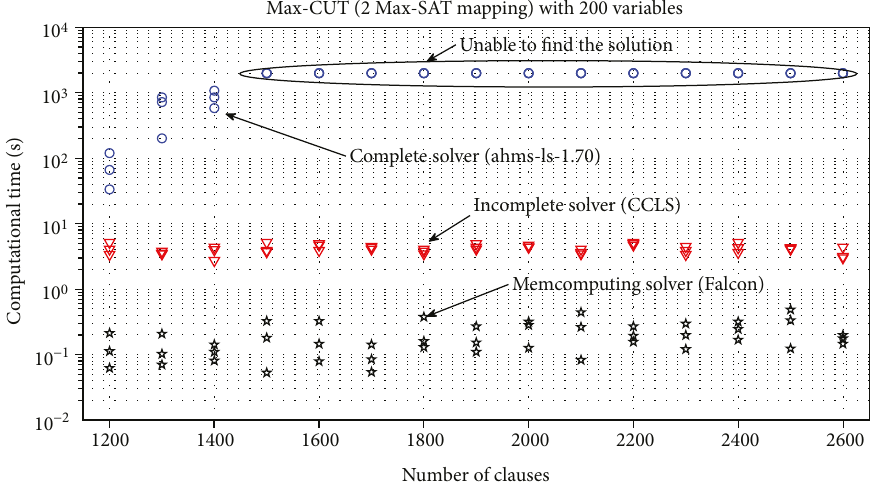
Figure 7: Results from the 2016 Max-SAT competition for the Max-CUT problem compared with our memcomputing solver,